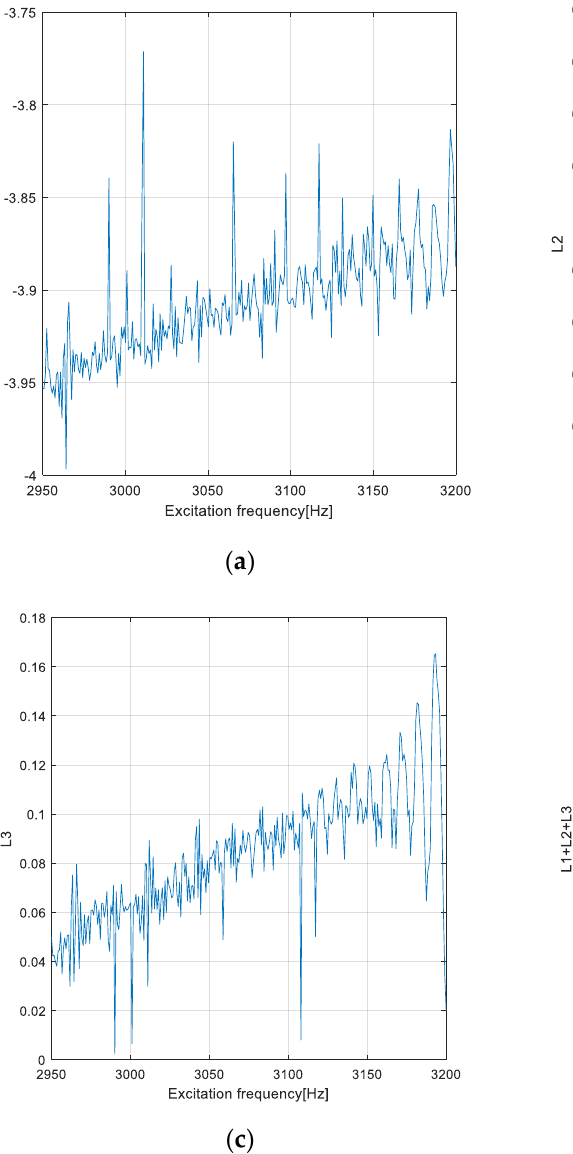
= 9 0 , ξ = 11 · 10 − 3 1